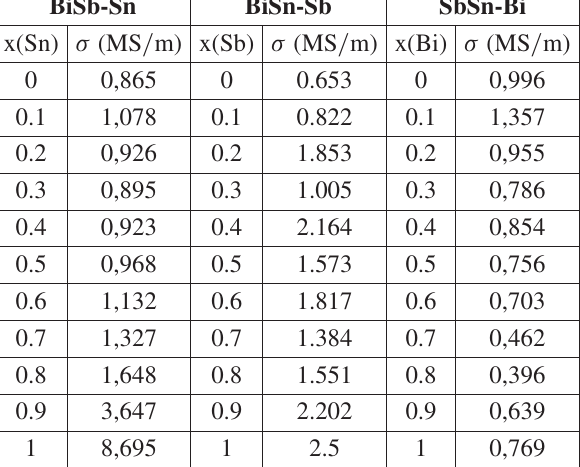
Table 2. Alloy compositions and electrical